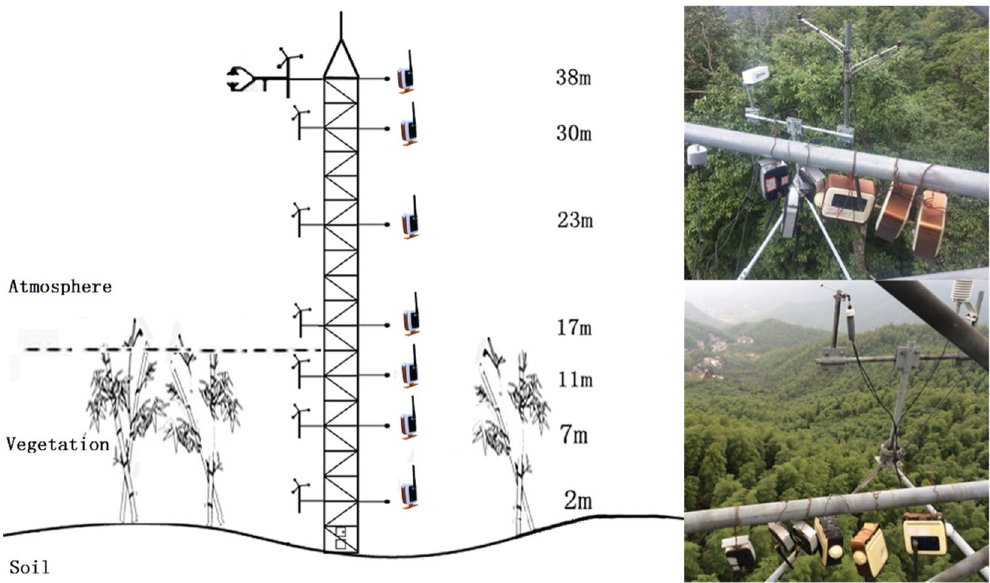
Figure 7. Layout of the wireless sensors on the flux towers.